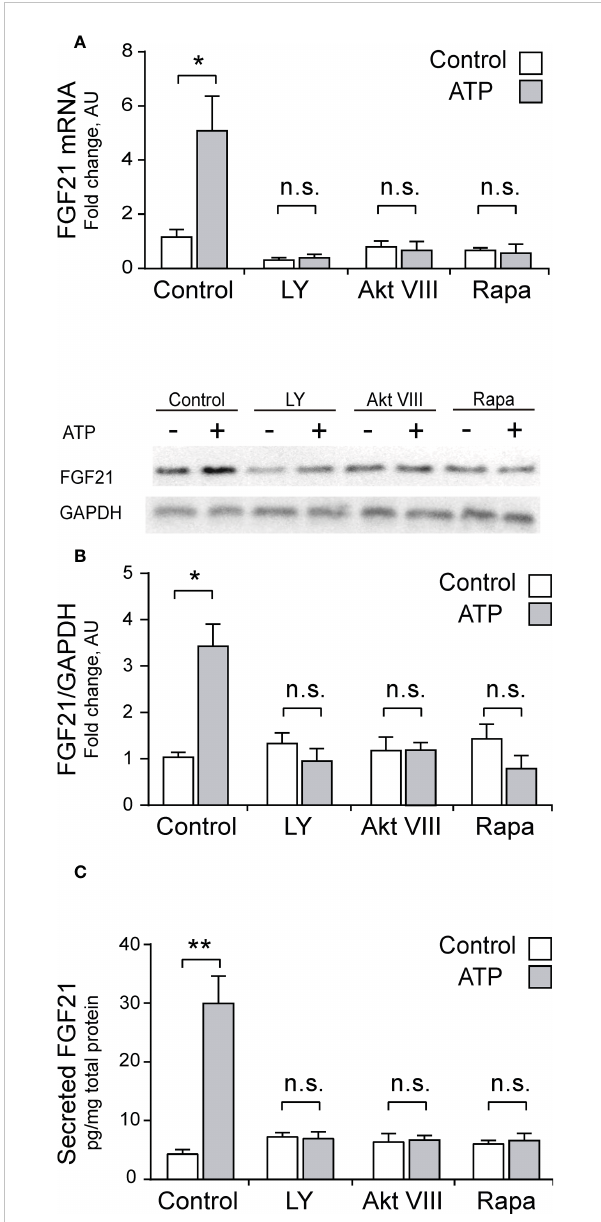
FIGURE 4 Pharmacological inhibition of PI3K-Akt-mTOR pathway abolished the increase in mRNA, protein and secreted FGF21 levels evoked by ATP stimulation, in whole-FDB muscle. LY294002 (50 m M), a general PI3K inhibitor, Akt VIII (10 m M), an Akt inhibitor, and Rapamycin (100 nM), a mTORC1 inhibitor, all blocked the 3 m M ATP stimulation effect on mRNA (A) , protein (B) , and secreted (C) FGF21 levels, in whole- FDB muscle. n=4; n.s., not signi fi cant; *p<0.05, **p<0.01, vs non- ATP Control; Mann-Whitney